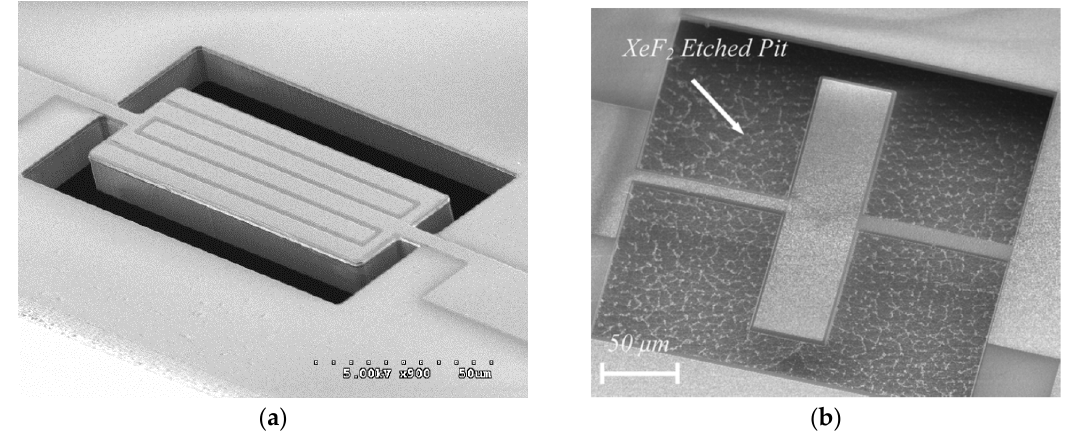
Figure 16. Scanning electron micrograph (SEM) of an AlN-on-Silicon fifth-order lateral-extensional mode ( a ) and an AlN contour-mode rectangular resonator ( b ) [135]. © 2007 IEEE. Reprinted with permission from Enhanced Power Handling and Quality Factor in Thin-Film Piezoelectric-on-Substrate Resonators by R. Abdolvand in Proceedings of the IEEE Ultrasonics Symposium, 2007.